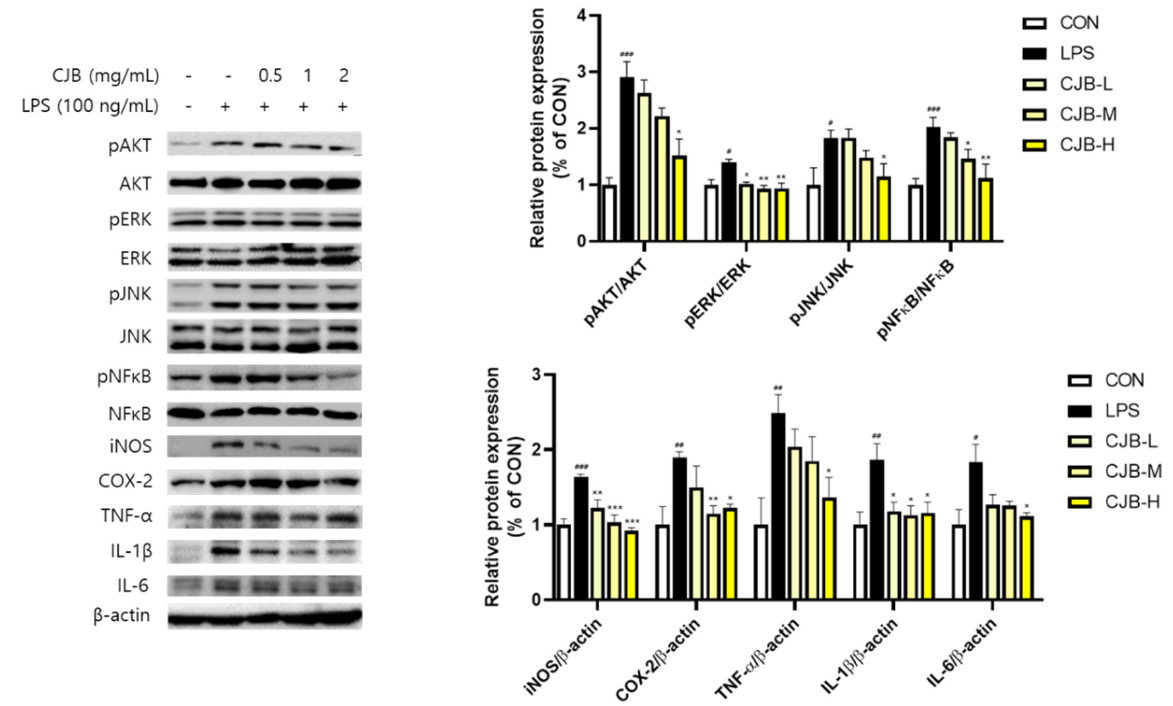
Figure 7. The expression of inflammatory proteins in LPS-treated RAW264.7 cell lines. All values are